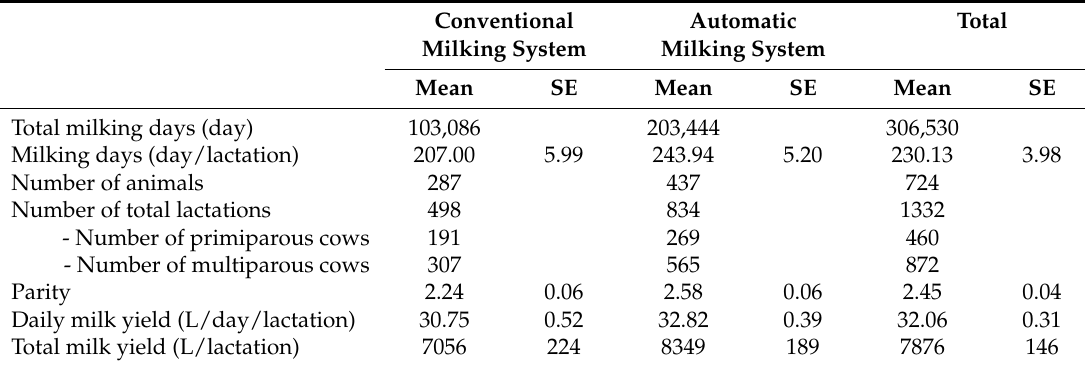
Table 1. Descriptive statistics of the raw data of milking